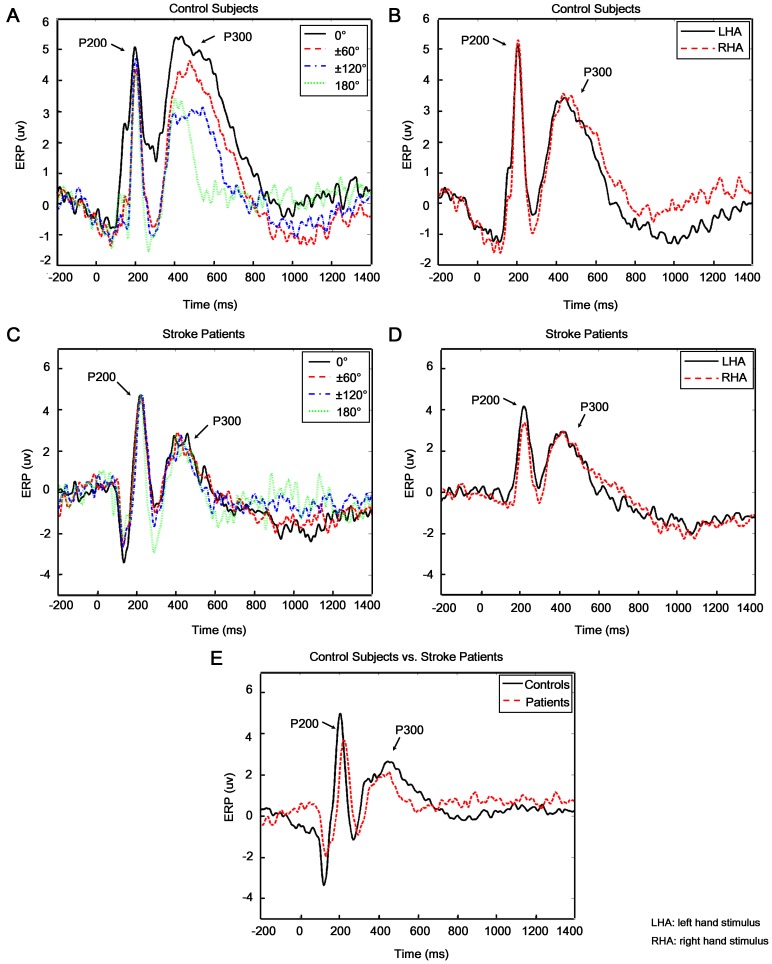
Event-related potential (ERP) results.
A and B: Grand-averaged ERP curves at P4 electrode for control subjects were shown in regard to ANGLE and HAND factors respectively. C and D: ERP curves at P4 electrode for stroke patients also with respect to ANGLE and Hand factors respectively. E: Comparison of grand-averaged ERP at P4 electrode between control subjects and stroke patients was shown. Stimuli were displayed on monitor at 0 ms. Baseline was from −200 ms to 0 ms, and two significant important components, i.e., P200 (0–300 ms) and P300 (300–800 ms) were indicated by arrows. No significant difference of P300 amplitude between 60° vs. 300° (p = 0.384), 120° vs. 240° (p = 0.293) was observed for all subjects. Thus only four ERP curves of 0°, ±60°, ±120° and 180° were illustrated in A and C.